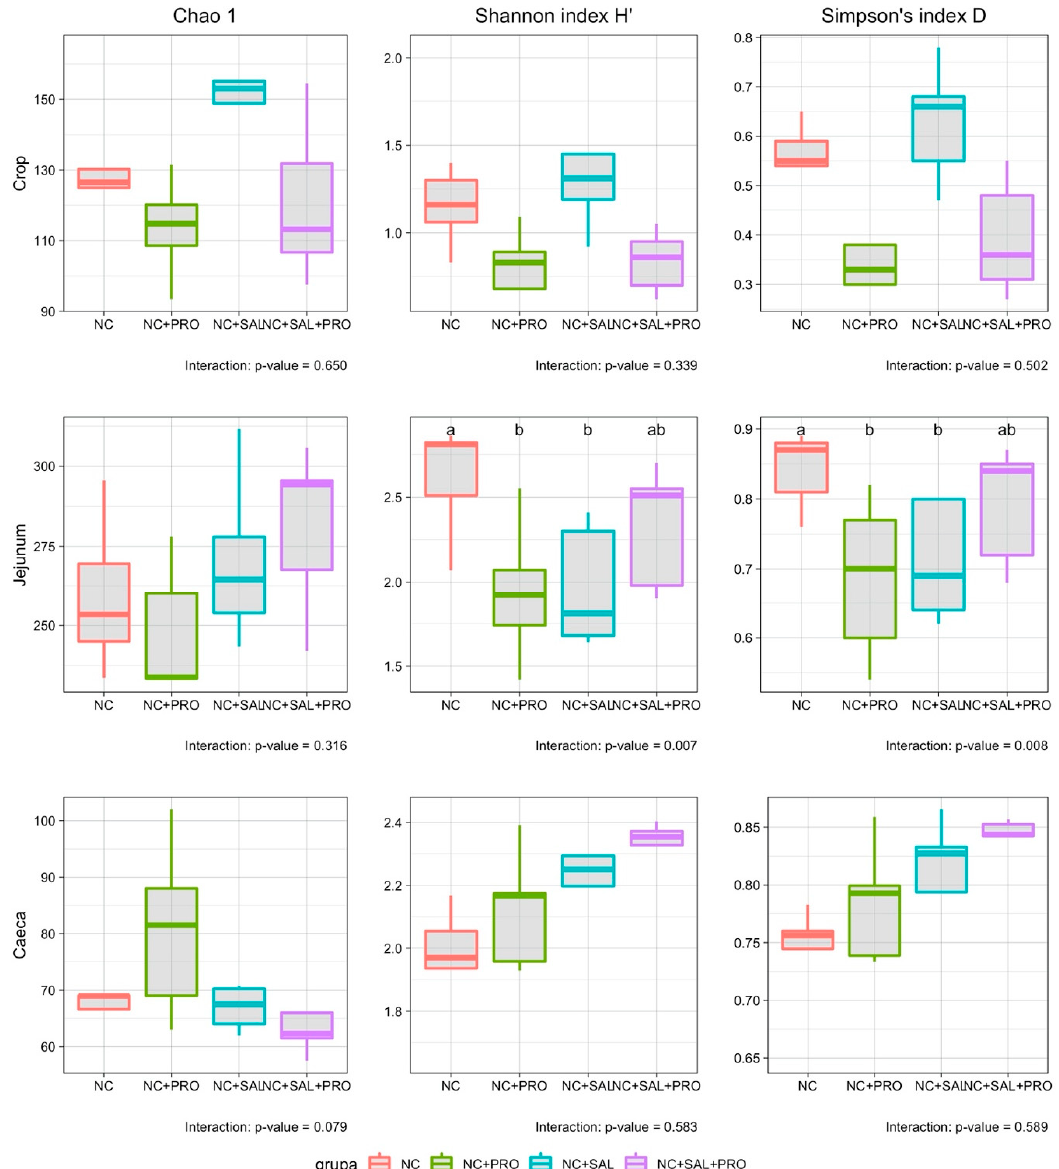
Figure 1. E ff ect of dietary supplementation of B. licheniformis alone or in combination with salinomycin on selected ecological indices of the gastrointestinal tract (GIT) microbiota in the crop, jejunum, and ceca of broiler chickens; means not sharing a common superscript di ff er significantly ( p < 0.05); NC—control diet with no additives; NC + PRO— B. licheniformis preparation (1.6 × 10 9 CFU / kg diet); NC + SAL—salinomycin addition (60 ppm); NC + SAL + PRO—a mixture of salinomycin (60 ppm) and B. licheniformis (1.6 × 10 9 CFU / kg diet); means represent 10 pens of one chick each pooled by two ( n = 5).